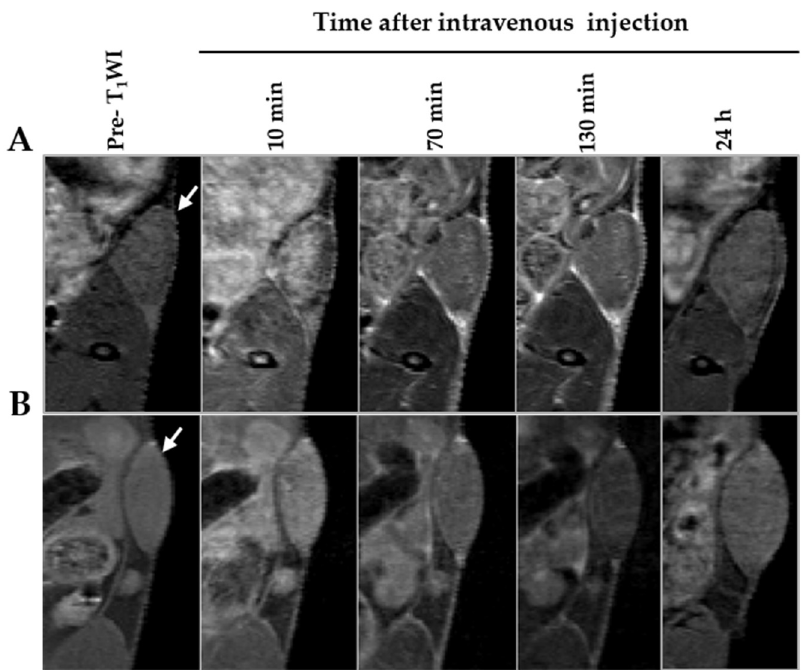
Figure 7. In vivo magnetic resonance imaging (MRI). T 1 -weighted MR images of B16-F10 melanoma tumor-bearing mice after the intravenous administration of Gd-DO3A-Am-PBA ( A ) or Gadovist ( B ) at different time points (pre-and post-injection of contrast agent at 10 min, 70 min, 130 min, and 1440 min) with 0.1 mmol/kg of gadolinium. The pre-contrast T 1 shown were acquired immediately prior to injection (0 min). Tumors are indicated by arrows.